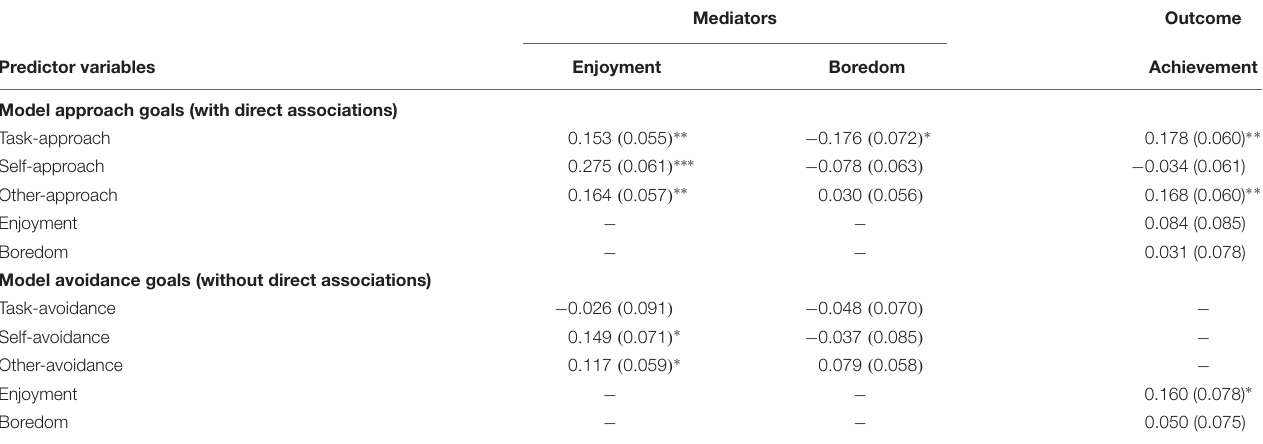
TABLE 5 | Multiple mediator models.